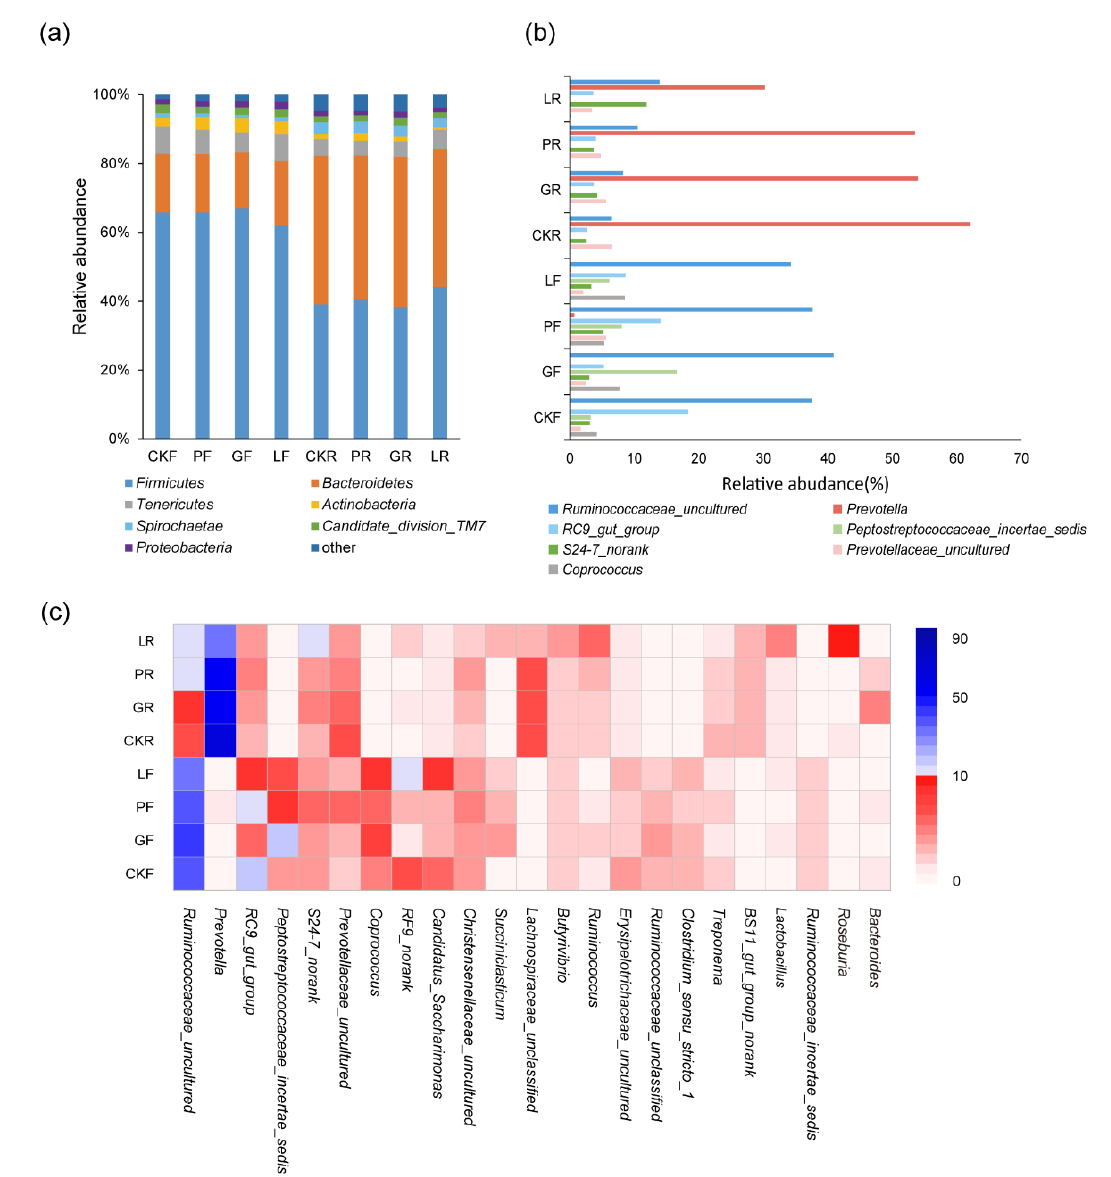
Figure 4. The influence of different treatments on the bacterial community structure in the rumen and feces of dairy cows. ( a ) The bacterial community structure composition at phylum level, ( b ) Relative abundance of dominant genera, ( c ) The top 23 bacterial genera in relative abundance in dairy cow samples. F: feces sample. R: rumen sample.